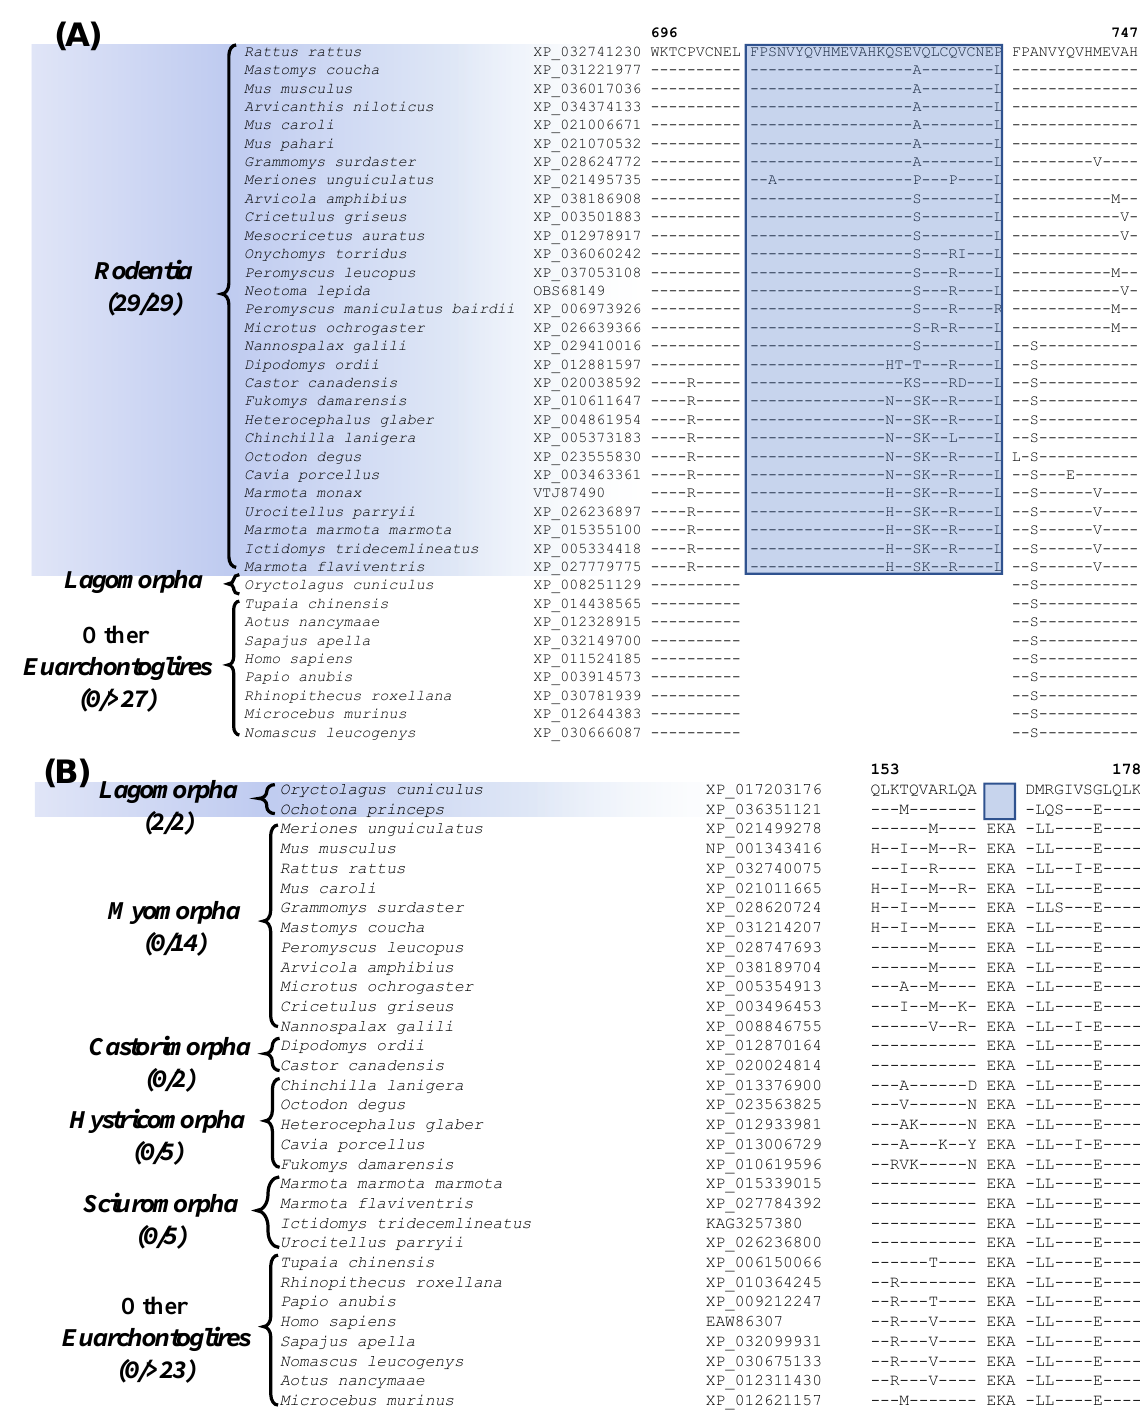
Figure 3. Partial sequence alignment of ( A ) activity-dependent neuroprotector homeobox protein 2 highlighting a 29 aa insertion that is specific for the species from the order Rodentia, and ( B ) partial sequence alignment of the protein optineurin, containing a 3 amino acid deletion, which is specific for the order Lagomorpha. Other details are the same as in Figure 1. Sequence information is shown here for only a limited number of outgroup species, but more detailed information is presented in the supplemental figures. Sequence information for three other CSIs specific for Lagomorpha is presented in Figures S5–S7 and summarized in Table